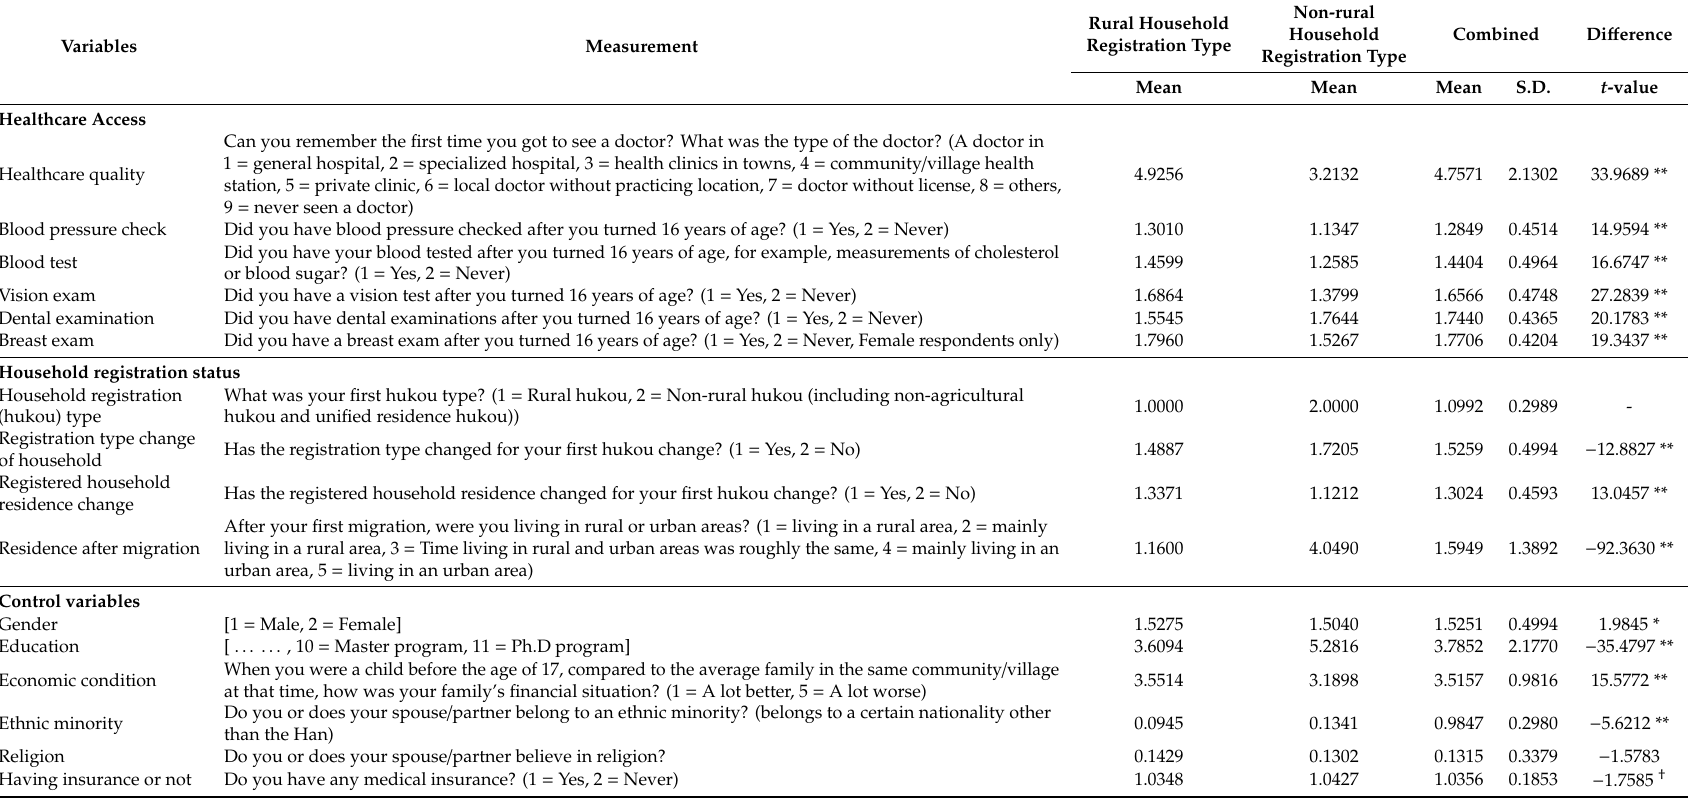
Table 1. Overview of the variables